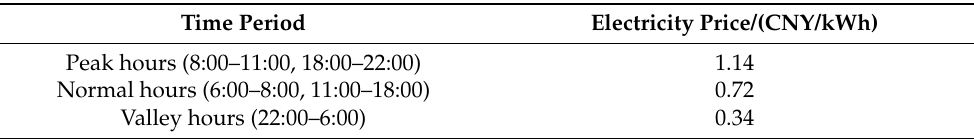
Table 5. Peak and valley tariffs for non-summer commercial and other electricity consumption in